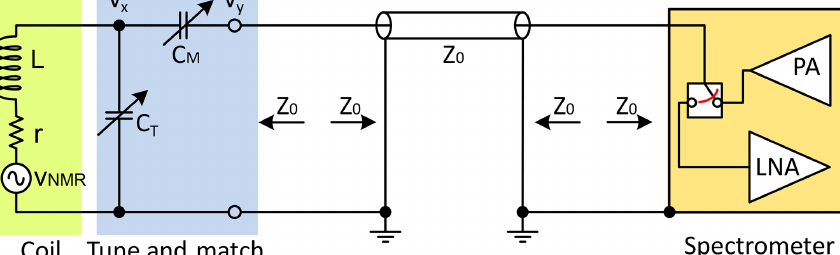
Figure 1. Example of a widely used parallel-tune/series-match topology. The L -matching circuit converts the complex impedance of the coil to a purely resistive impedance equal to the characteristic impedance of the coaxial cable, Z 0 .